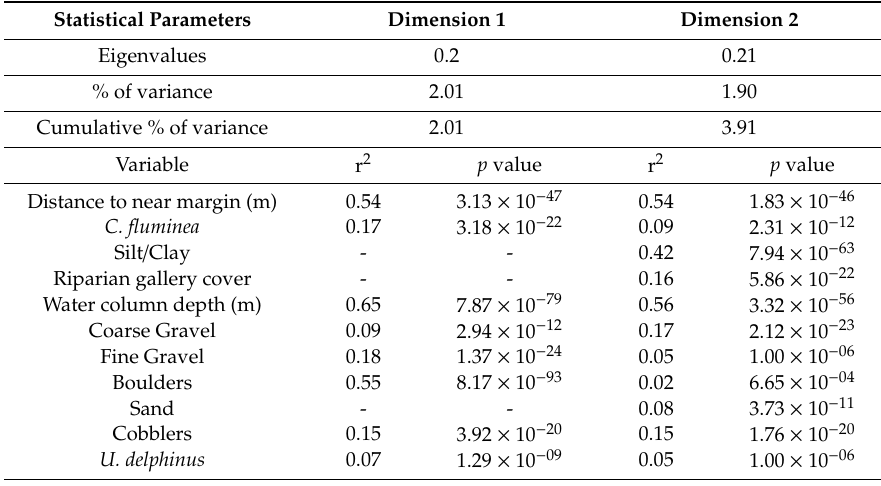
Figure 2. Estimated population size ( n ) of U. delphinus (top) and C. fluminea (below) in six pool sites (A–F) along the Oeiras river. Table 3. Statistical parameters from multiple correspondence analysis on factors explaining the distribution of U. delphinus and C. fluminea in six